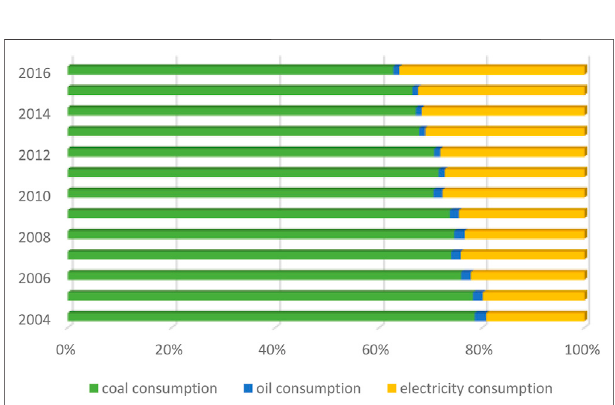
FIGURE 2 | Fuel consumption structure in China ’ s